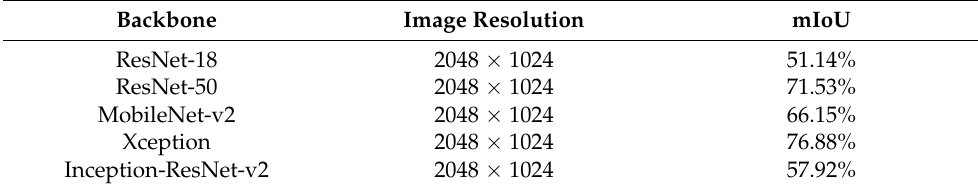
Table 5. Comparison of results with different pre-trained networks with improved parameters.